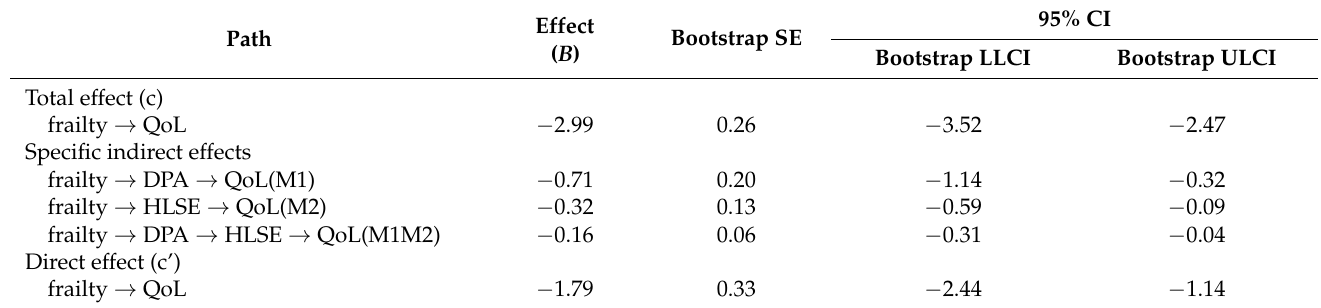
Table 4. Bootstrapping indirect effects and 95% confidence intervals (CI) for the final mediation